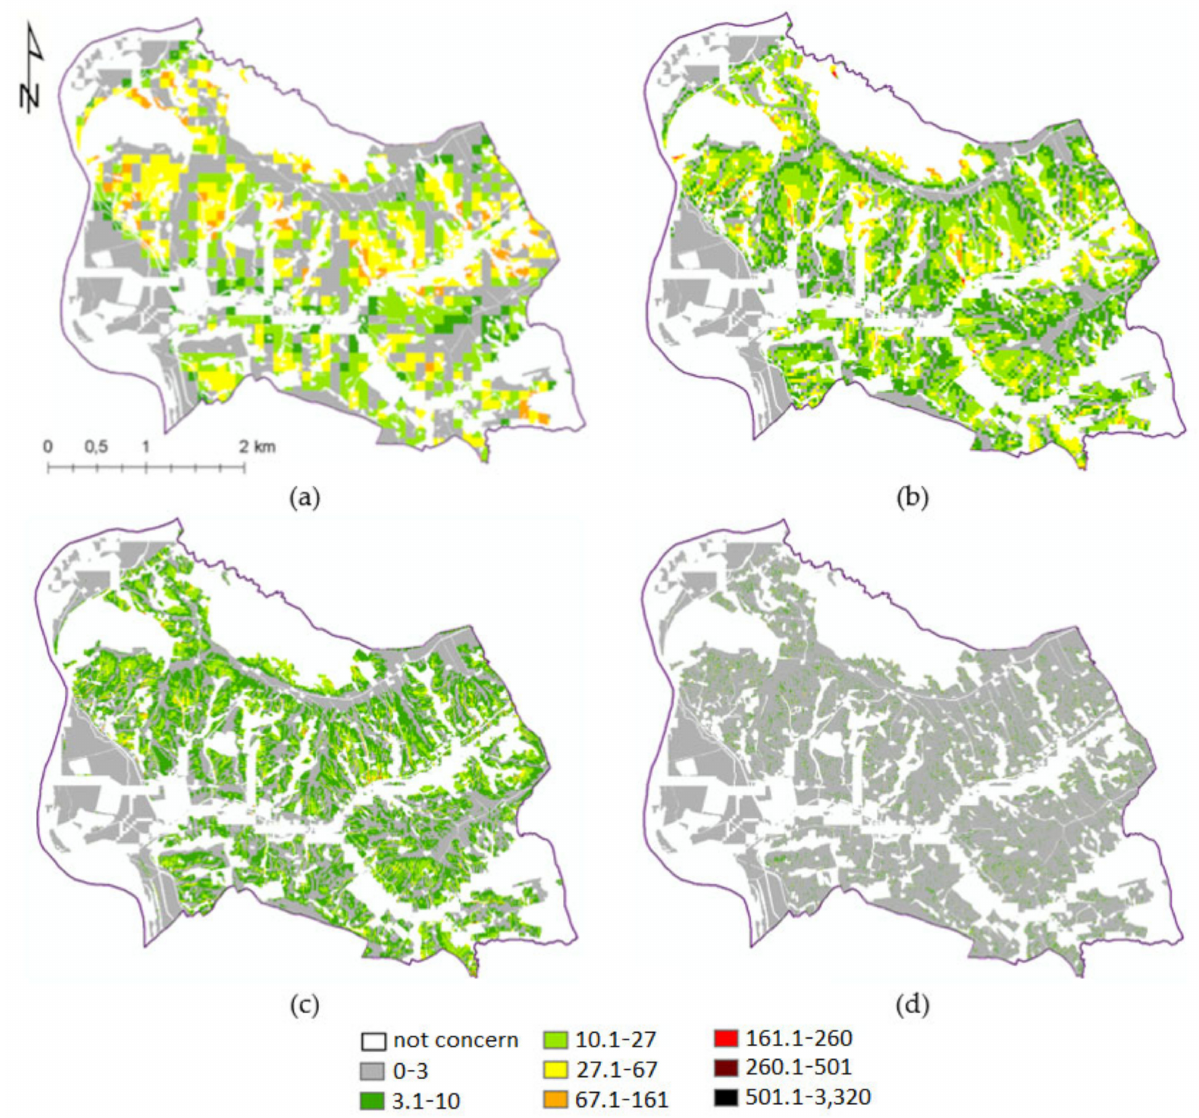
Figure A1. Visualisation of the values of the total LS factor values (classes) calculated from SRTM ( a ), DTED2 ( b ), LPIS ( c ) and ISOK ( d ) for the Janowice research